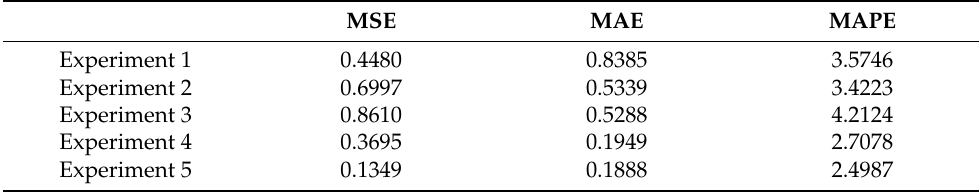
Table 7. Results of ablation